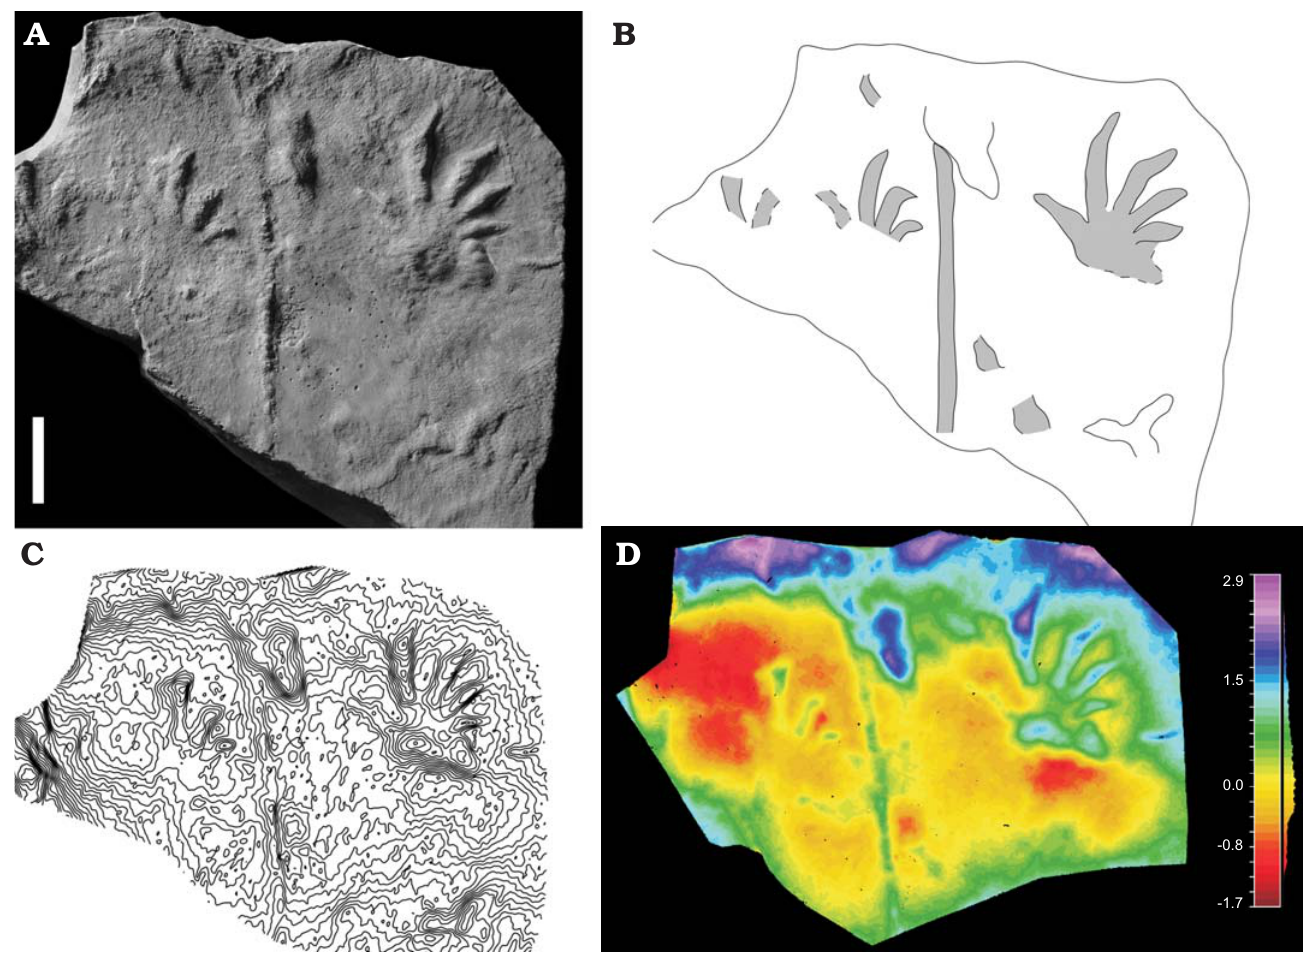
Fig. 7. Lacertoid neodiapsid eureptile trace Rhynchosauroides isp. (MCV 65) from Merendaore (Italy), Lopingian. Complete right manual impression. An incomplete track and a continuous tail are preserved on the same slab. Convex hyporelief (plaster cast), spacing 0.5 mm. Photo ( A ), interpretive drawing ( B ), contour lines ( C ), false-color depth map ( D ). Scale bar 10